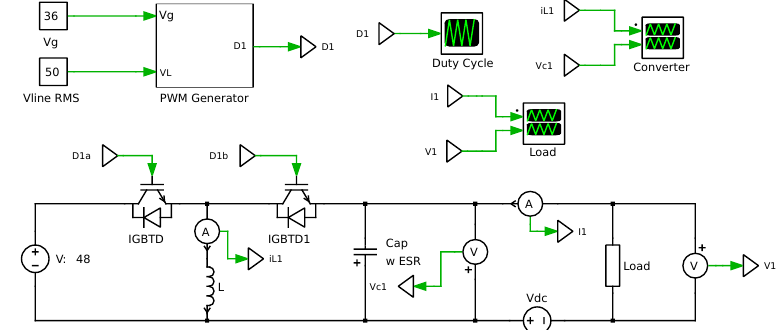
Figure 8. Single-phase equivalent circuit model PLECS schematic.